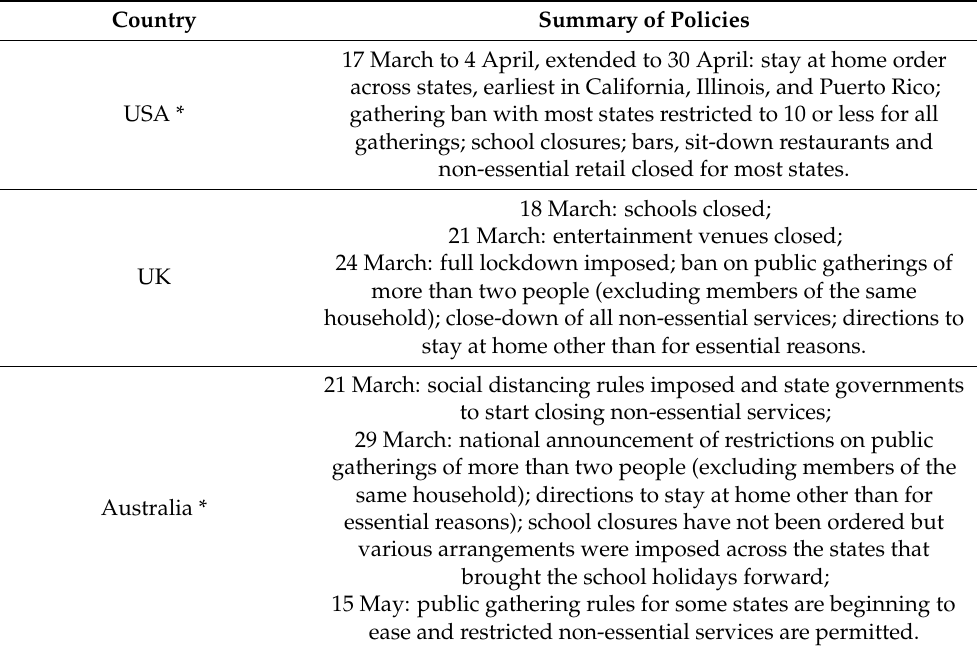
Table A1. Summary of social distancing policies in place across the three countries during the study period. Country Summary of Policies 17 March to 4 April, extended to 30 April: stay at home order gathering ban with most states restricted to 10 or less for all USA * non-essential retail closed for most